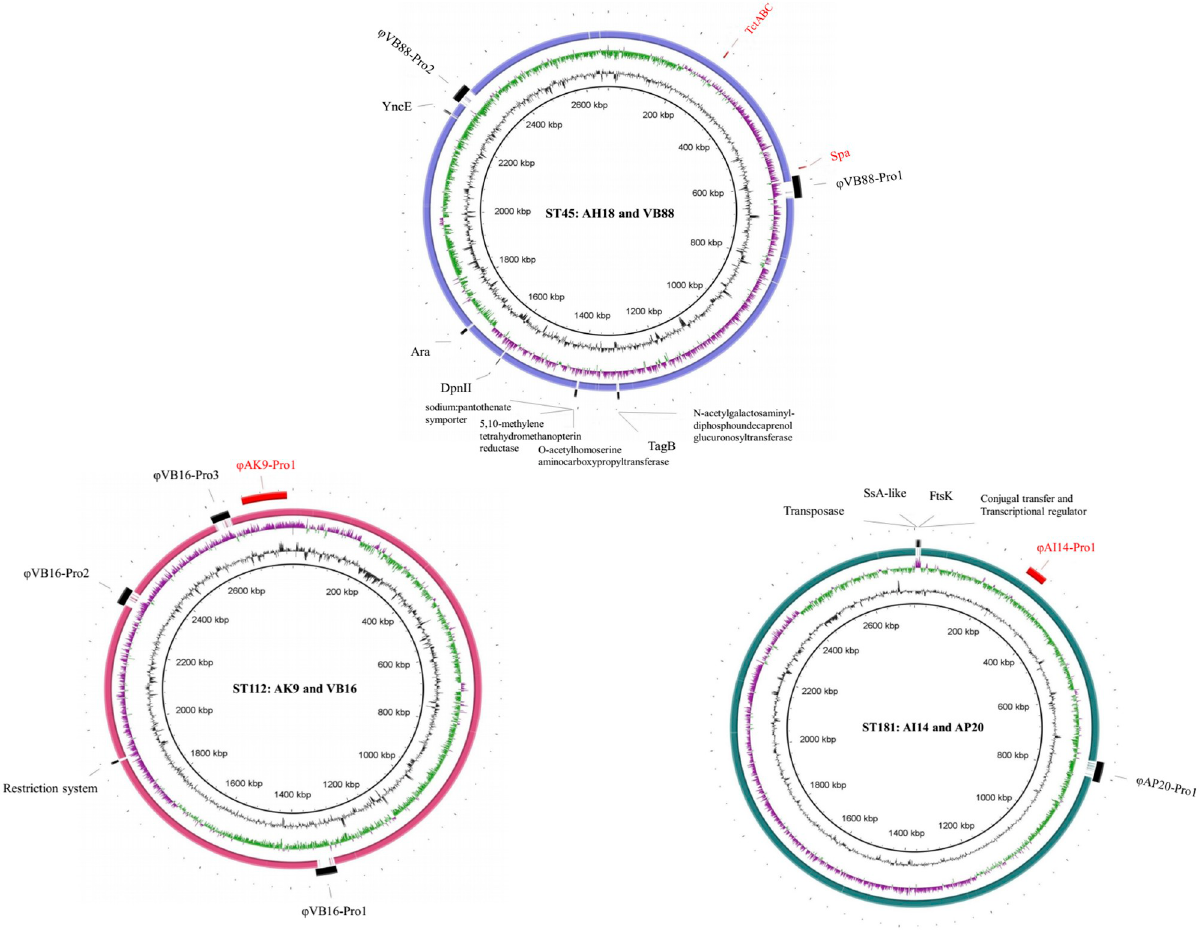
Fig 1. Genomic comparison of three representative pairs of methicillin-resistant S . pseudintermedius (MRSP) strains isolated from dogs and humans belonging to ST45, ST112, and ST181. Human strains were used as the reference. Circular diagram from inner to outer rings represent the % GC, GC skew (green-/ purple+), homology, location and difference in genes and prophages in human (black label) and dog (red label) isolates.